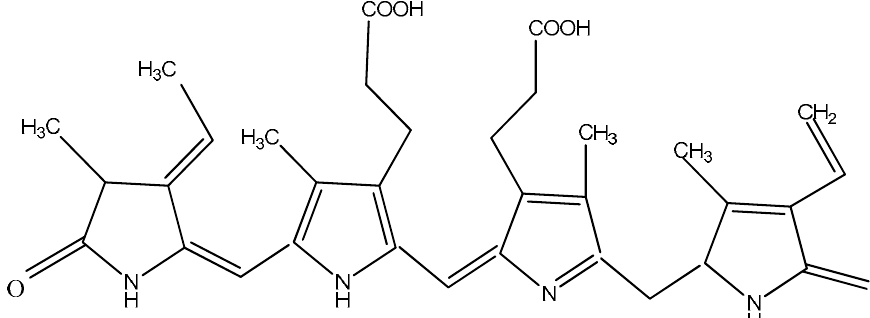
Figure 2. Structure of phycoerythrin.